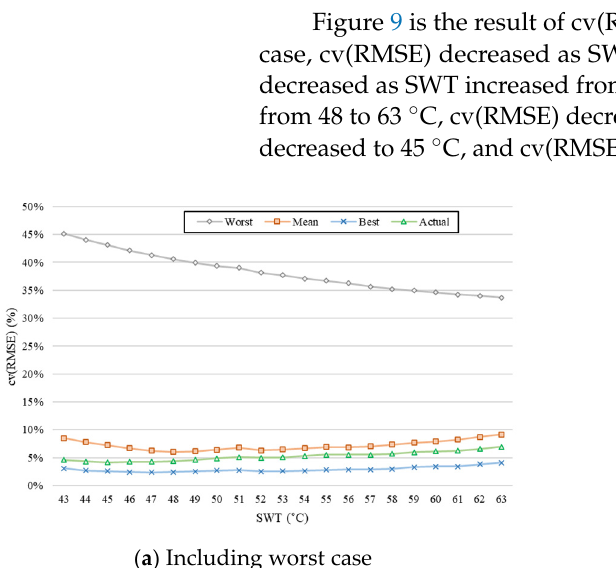
Figure 9. The cv(RMSE) according to the supply water